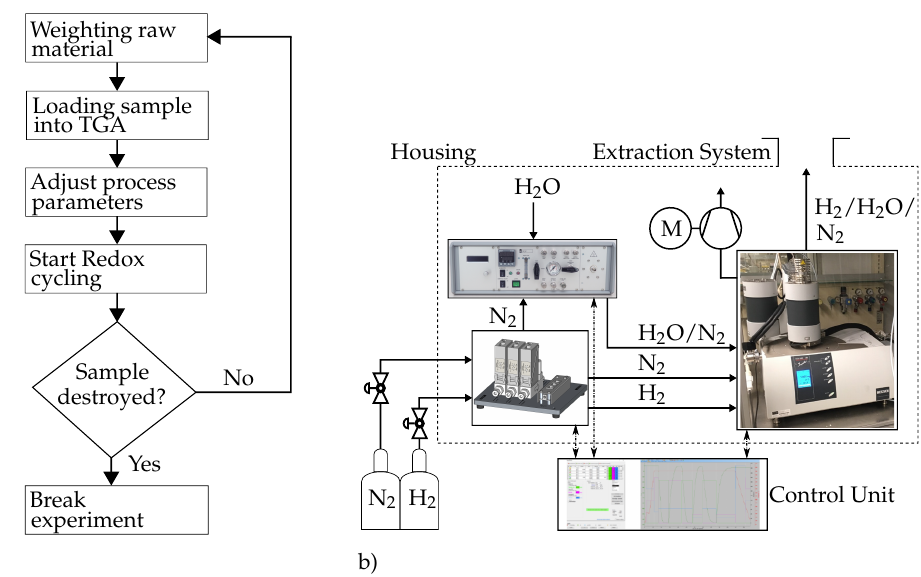
Figure 2. ( a ) Flowchart for the experimental procedure; ( b ) TGA setup for the experimental investi- gation of the kinetics of the redox reactions.